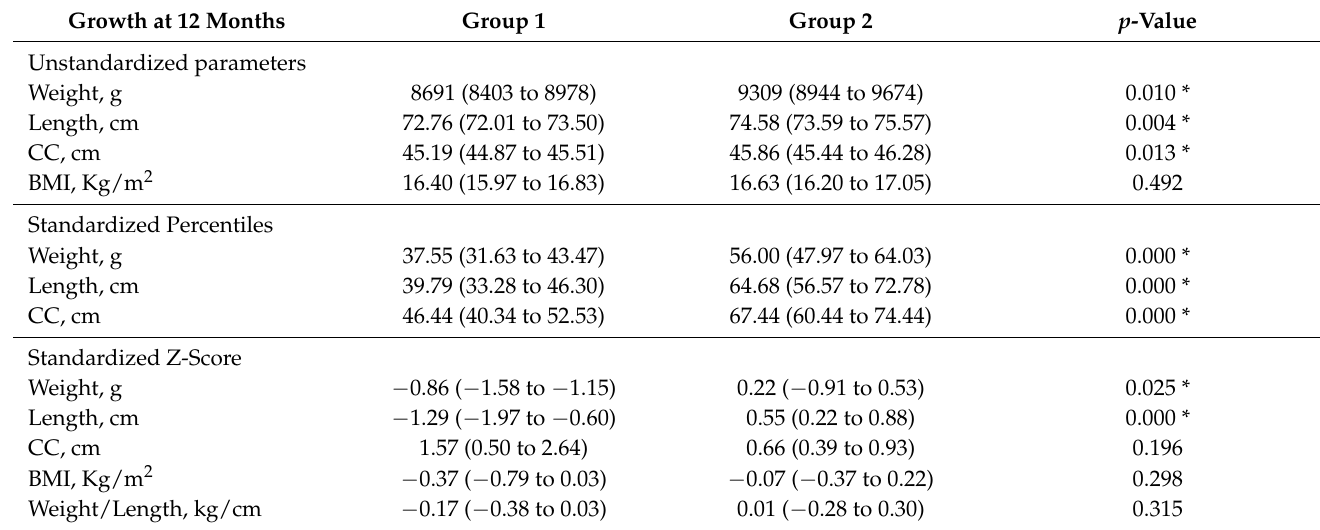
Table 6. Growth at 12 months of life in the two groups of